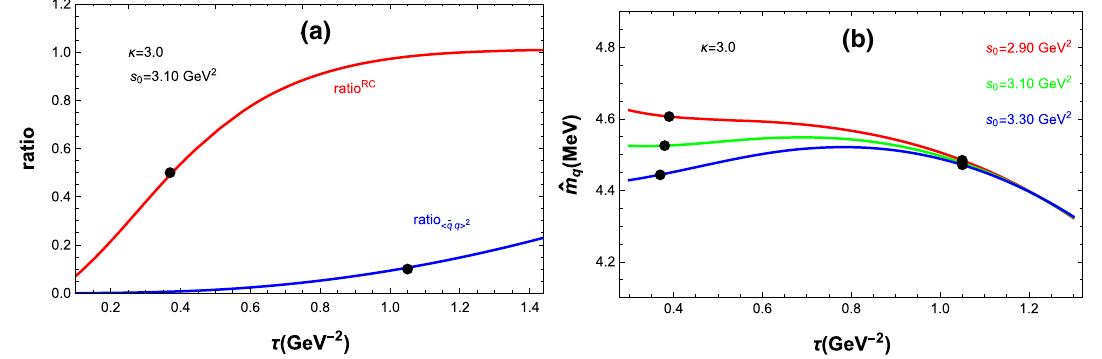
Fig. 5 a The OPE convergence ratio (cid:2)¯ qq (cid:3) 2 and the resonance contribu- tion ratio RC as functions of the Borel parameter τ with s 0 = 3 . 10 GeV 2 and κ = 3 . 0. The blue and red lines represent ratio (cid:2)¯ qq (cid:3) 2 and ratio RC ,